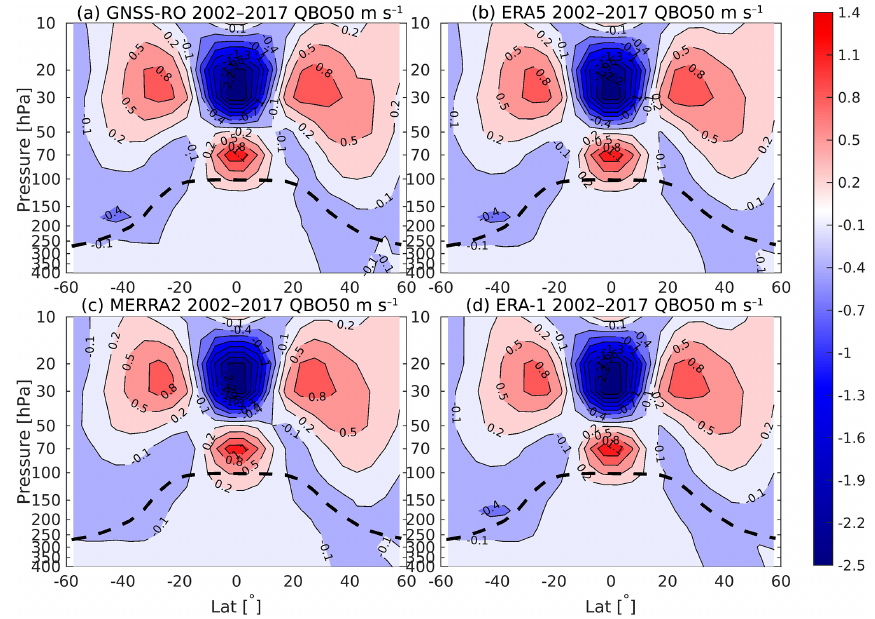
Figure 9. As in Fig. 8 but for